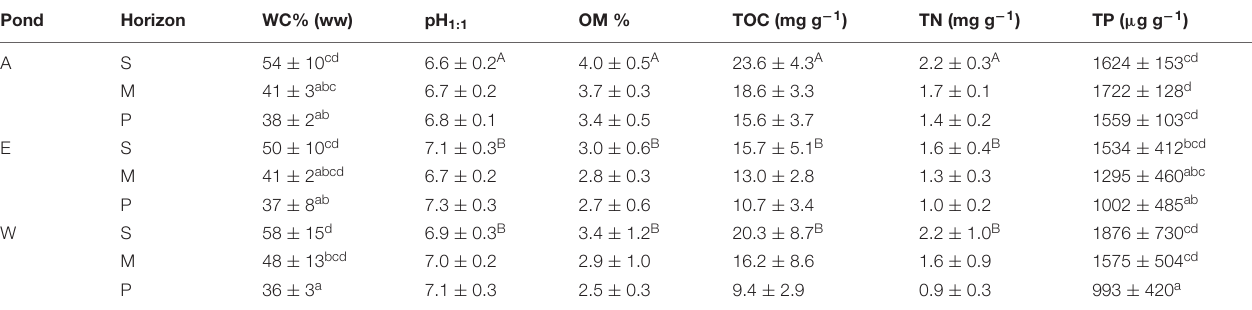
Upper-case letters indicate the groups of ponds differentiated by the two-way ANOVA. Lower case letters show the groups of ponds differentiated by the non-parametric Kruskal-Wallis test. In this last case, data are not normally distributed.